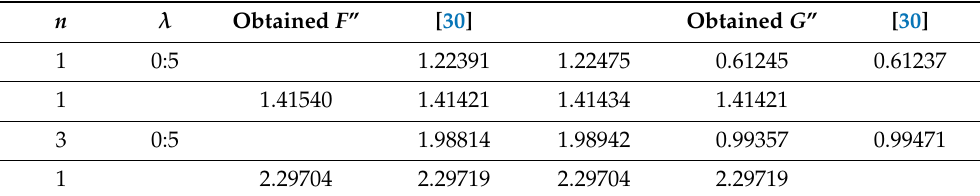
Table 3. Comparison of the obtained solutions for F (cid:48)(cid:48) and G (cid:48)(cid:48) with the existing results [30] when N R = ∞ , M = φ = Ec = 0 and Pr = 0.5.